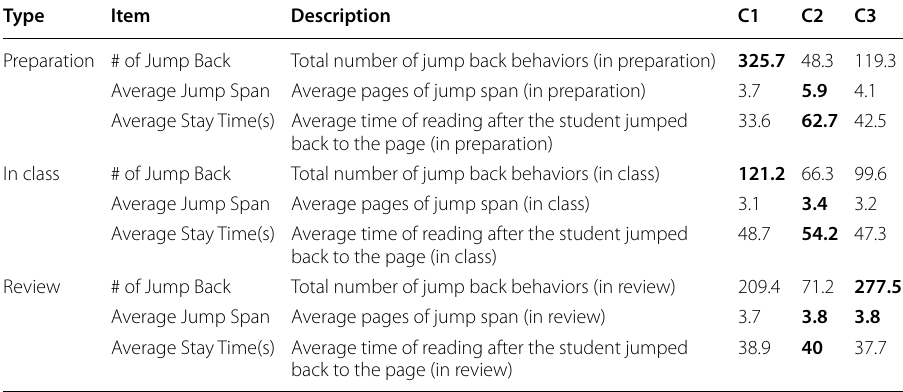
The largest value in each row is highlighted with bold text